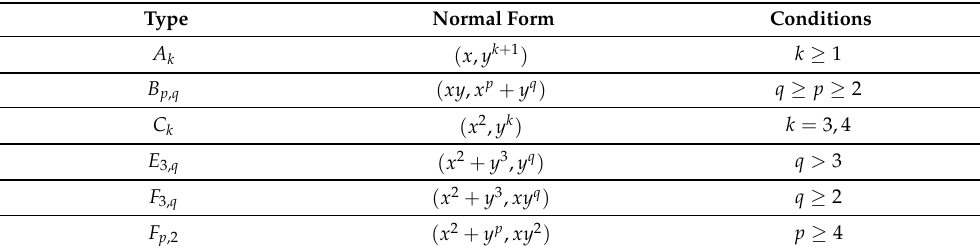
Table 1. Normal form of simple map